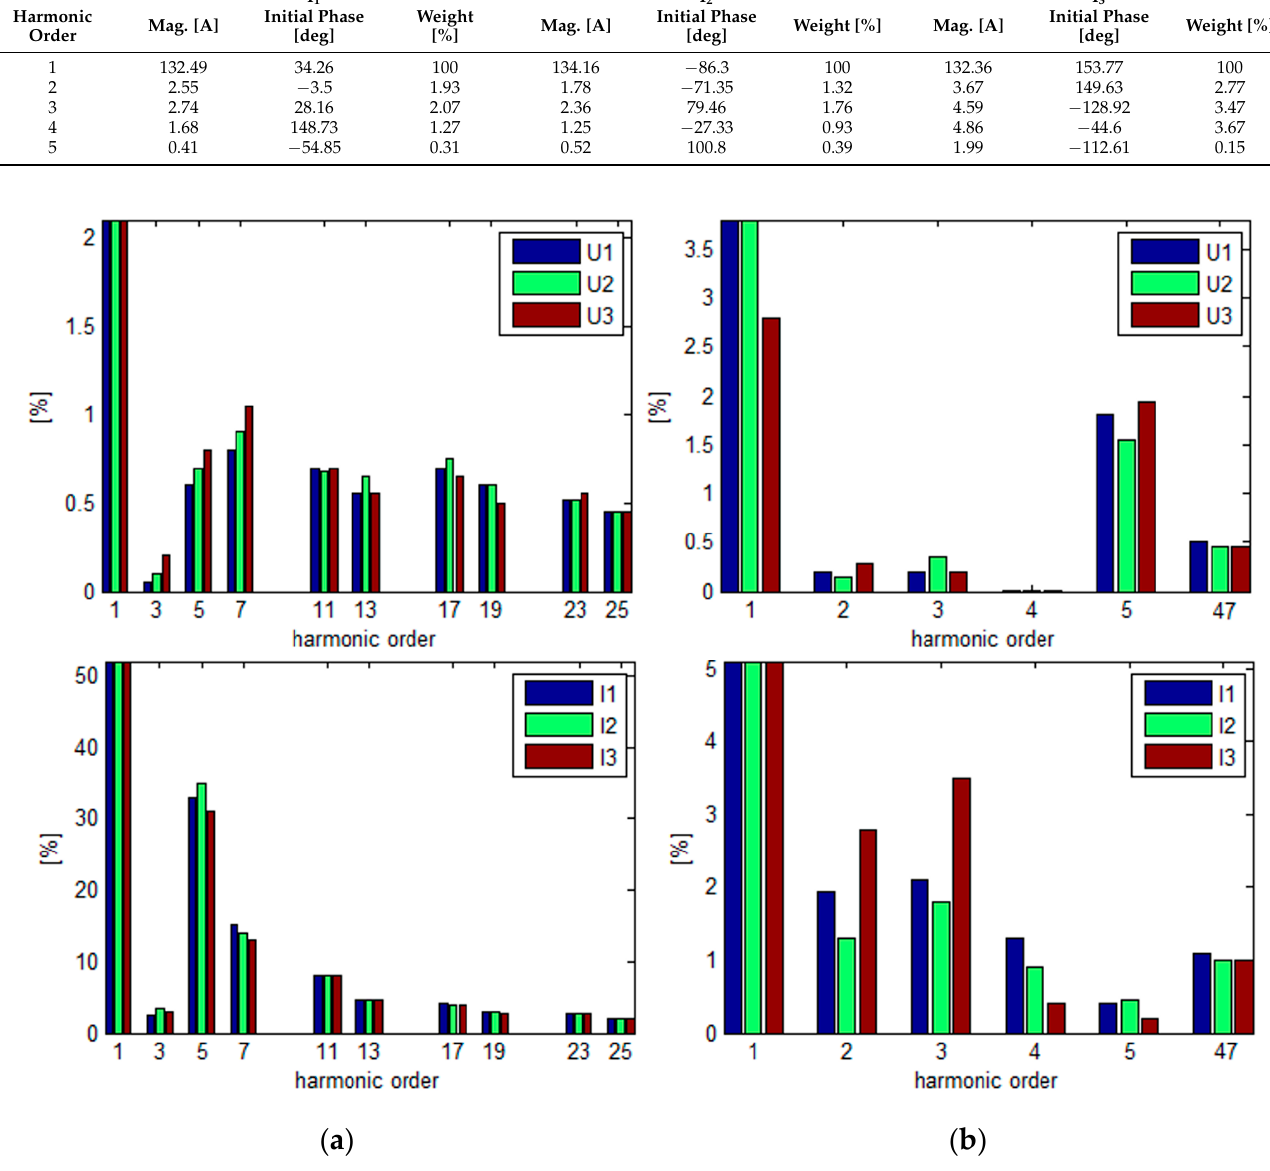
Figure 11. Representative harmonic spectra computed with FFT for voltages (top) and currents (bottom). ( a ) Before compensation; ( b ) after compensation.